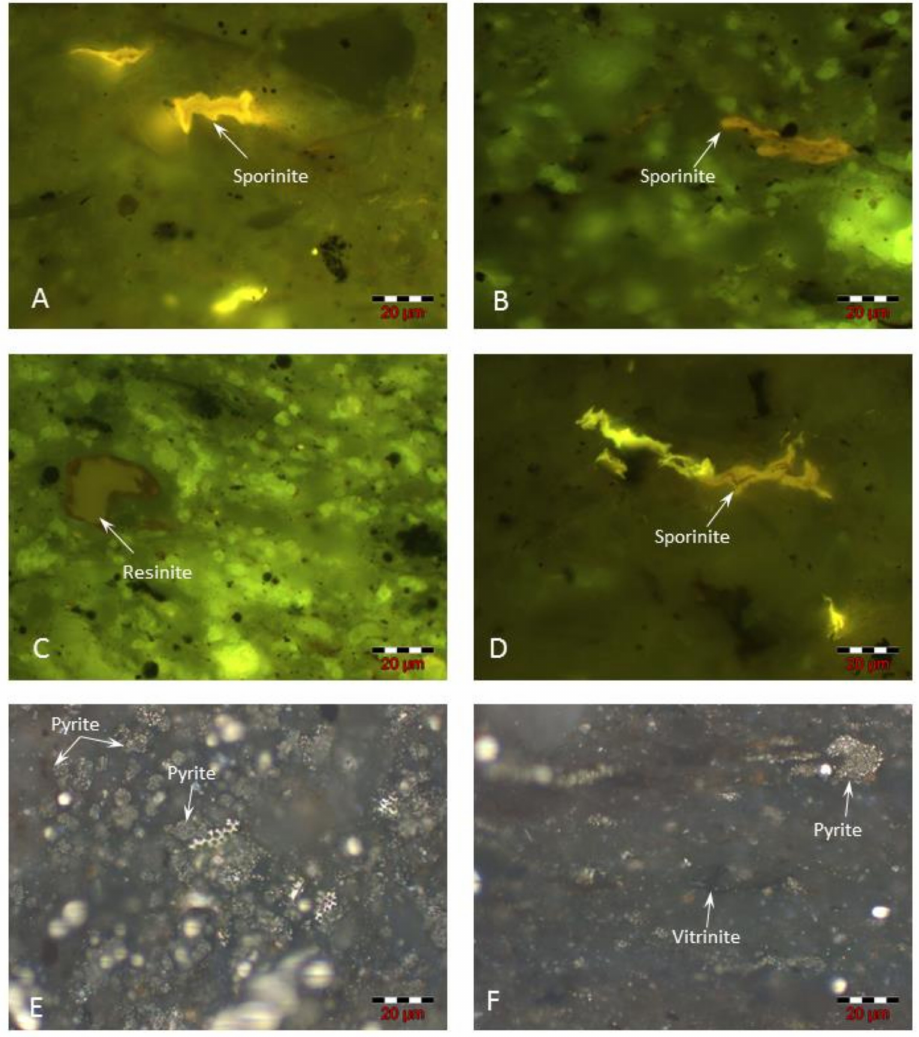
Figure 8. Photomicrographs of phytoclasts, altered spores (A-1, 2, 3 Bibes